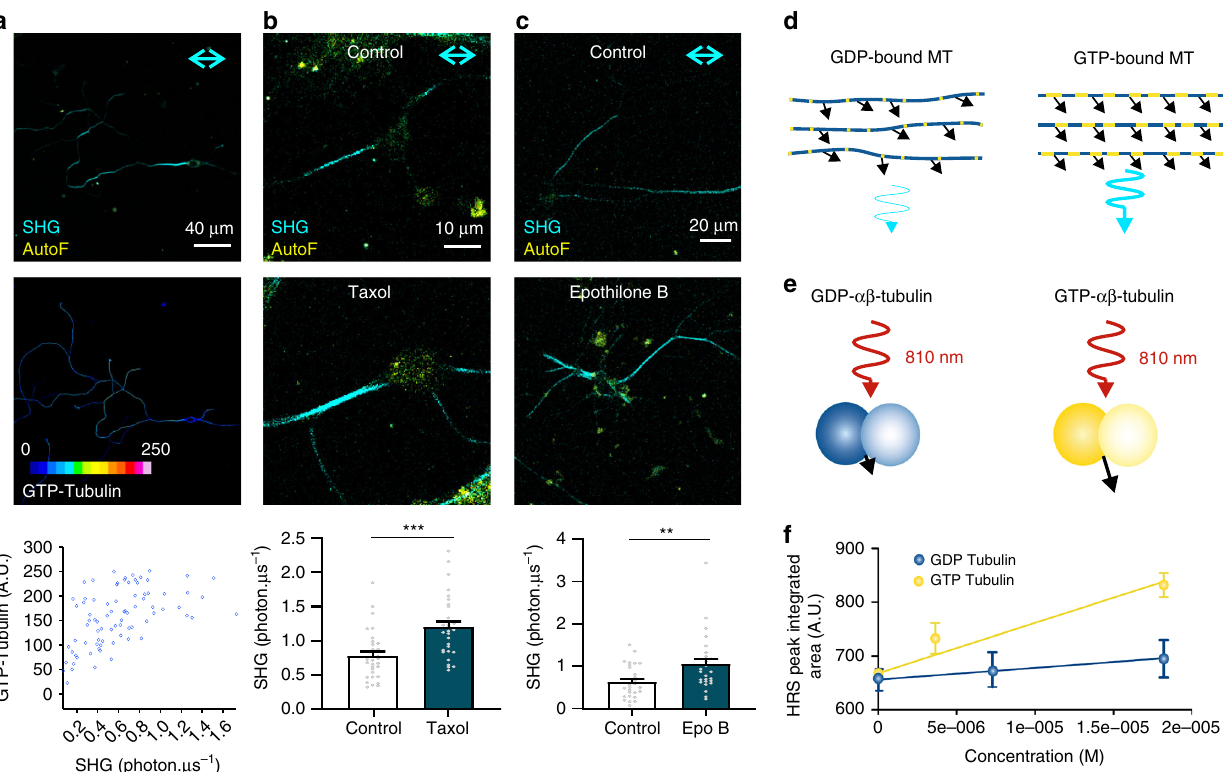
Fig. 5 SH signals originate from the GTP-bound tubulin dimer conformation. a SH signals positively correlate with MB11 (GTP-bound tubulin